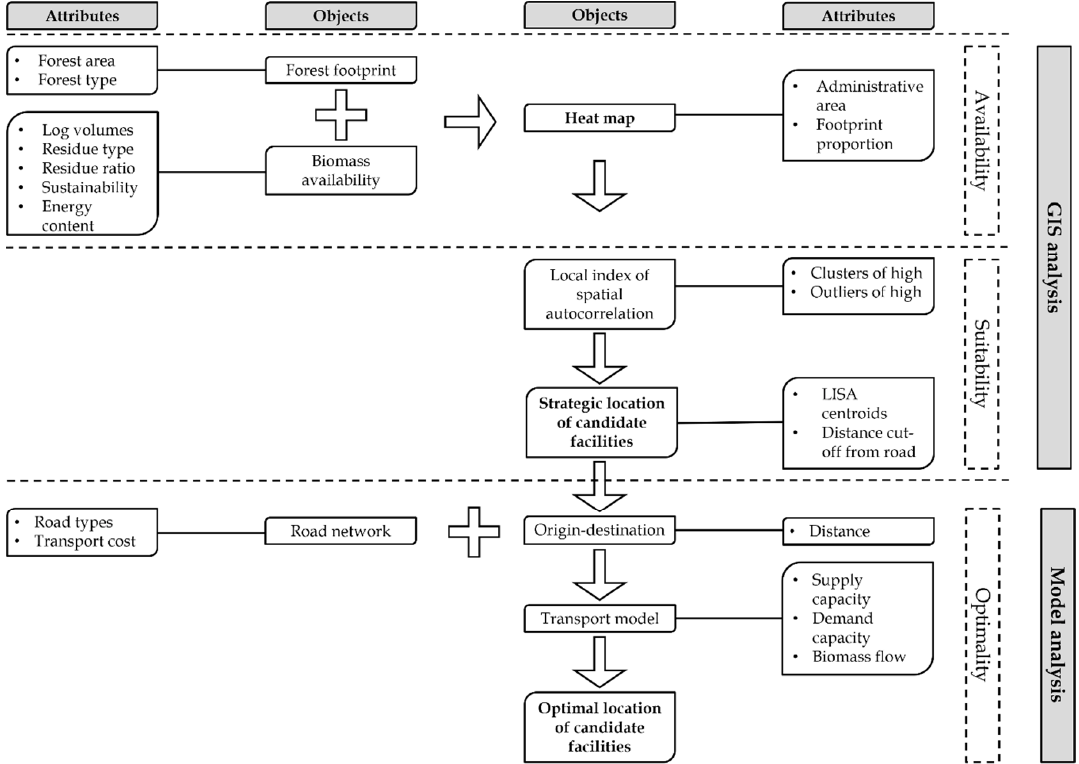
Figure 1. An overview of the developed methodology.